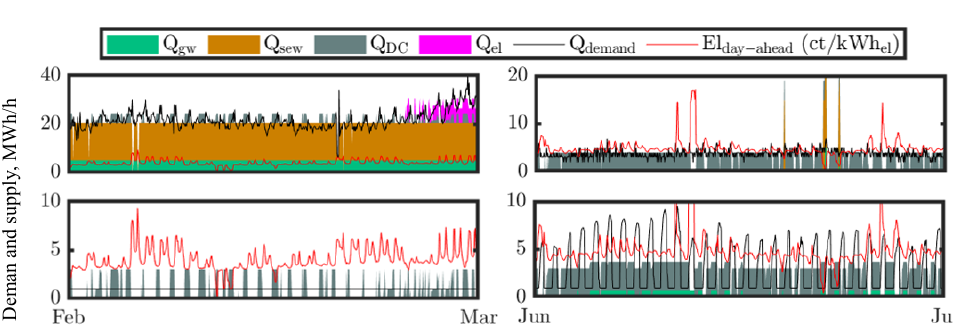
Fig. 5. Hourly supply of DH (above) and DC (below) and electricity day-ahead prices for January and February.